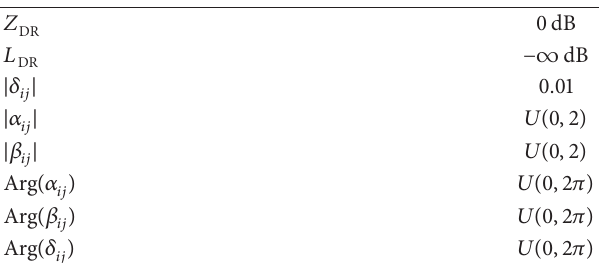
Table 2: Simulation parameters.